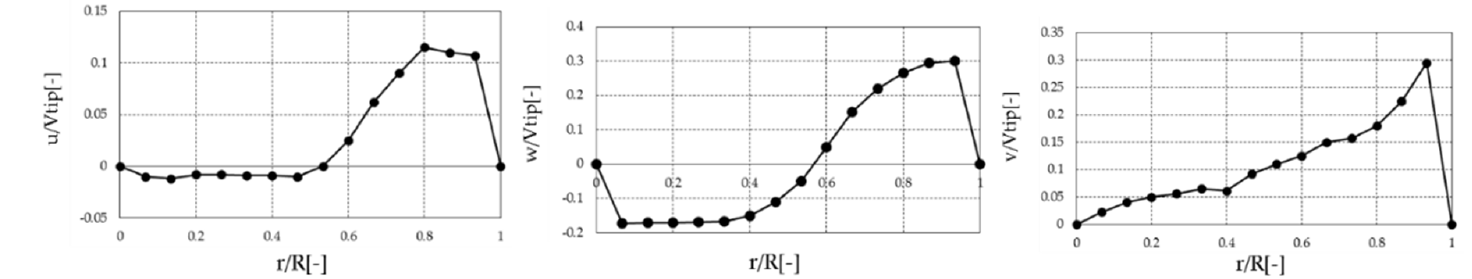
Figure 4 . Initial and boundary conditions for the numerical calculations.